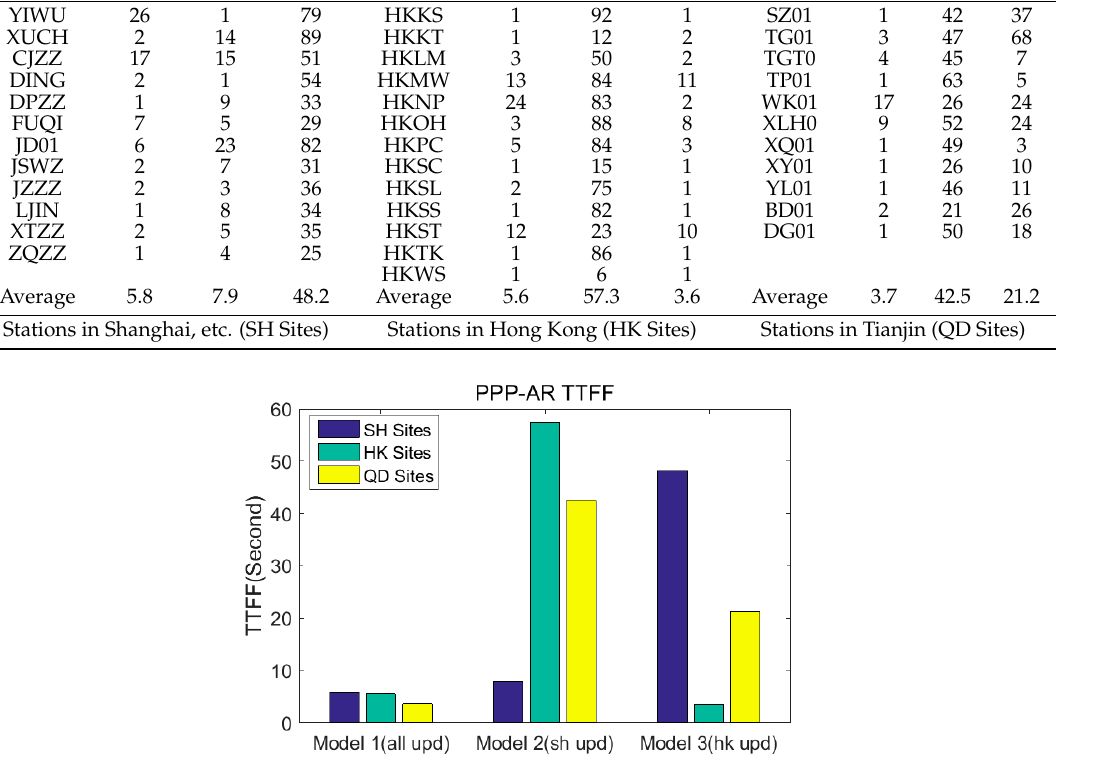
Figure 10. Average TTFF for RTPPP-AR of different regional stations in different UPD models (reference station coordinates are set to known).